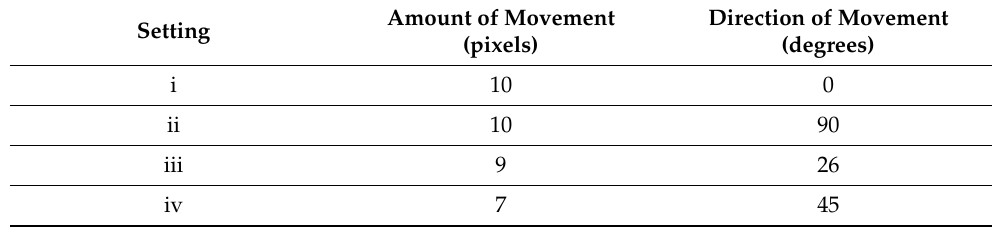
Table 2. Settings of the blur